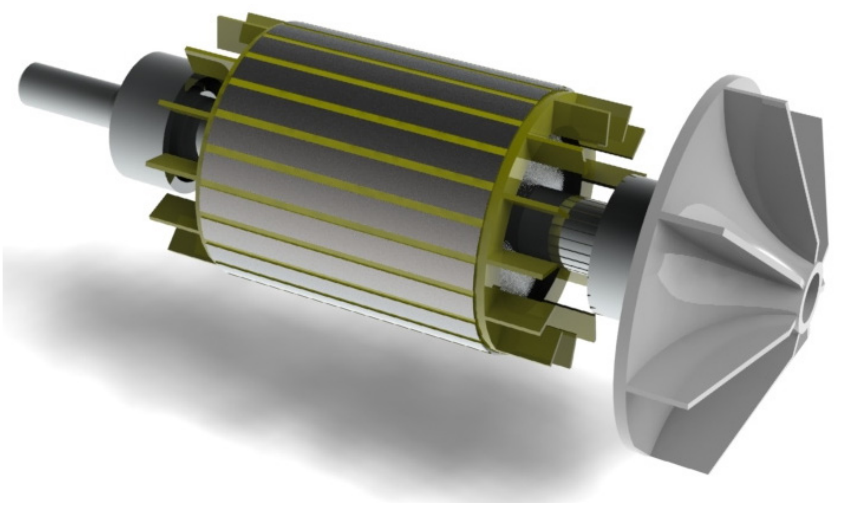
Figure 13. CAD model in SolidWorks software.